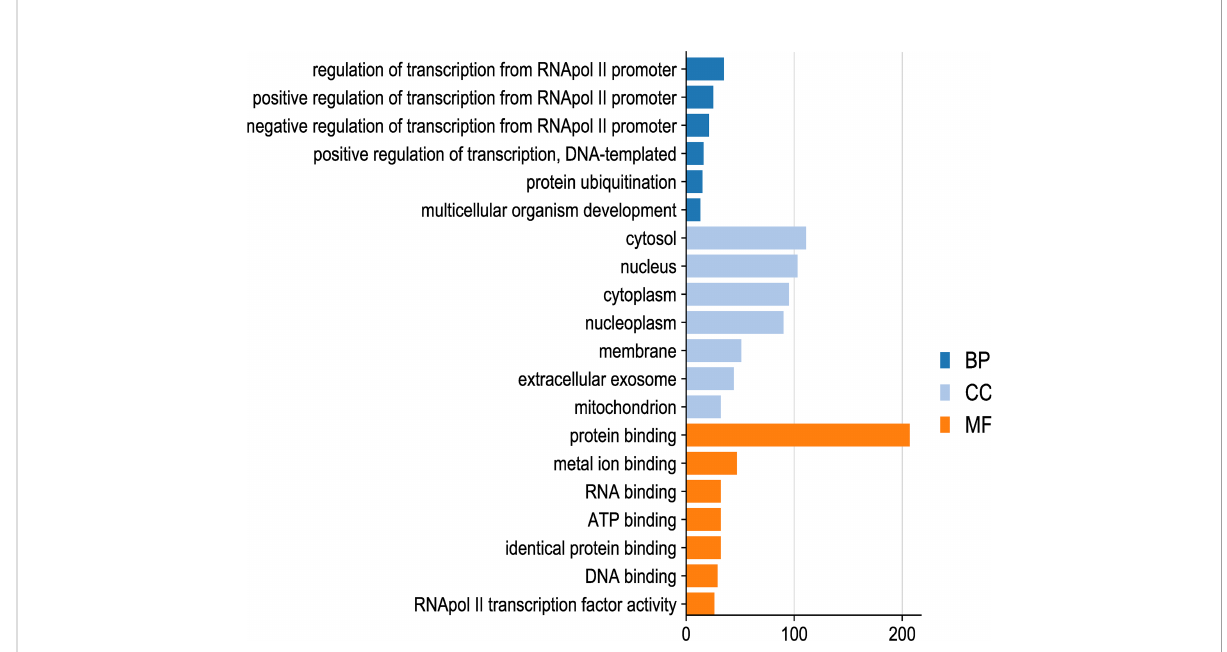
FIGURE 1 Gene Ontology (GO) analysis for all downregulated genes after EV-A71 infection on glioma cells. The distribution of downregulated genes from EV-A71 groups was obtained relative to the mock infection. GO analysis for all downregulated genes was performed and many enriched GO categories were